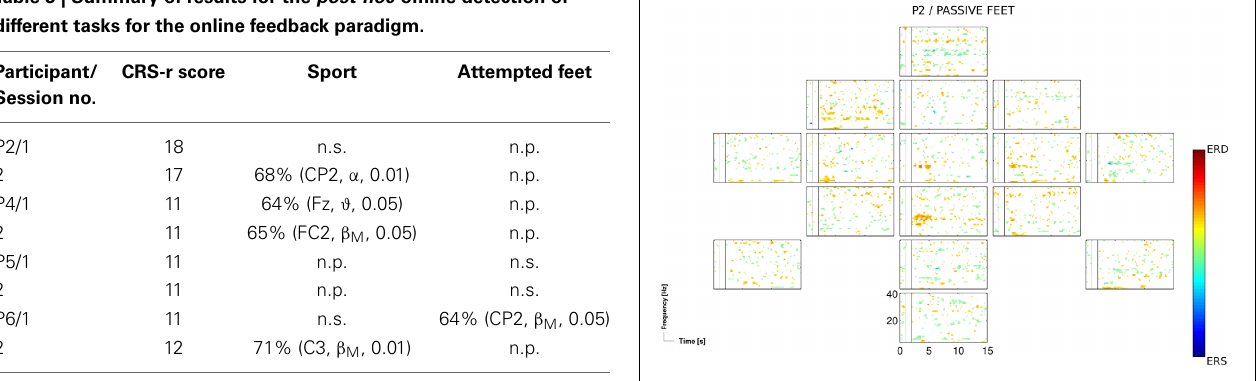
FIGURE 3 | ERD/S map for the participant P2 and for the passive feet condition of the 3rd session, calculated for Laplacian channel